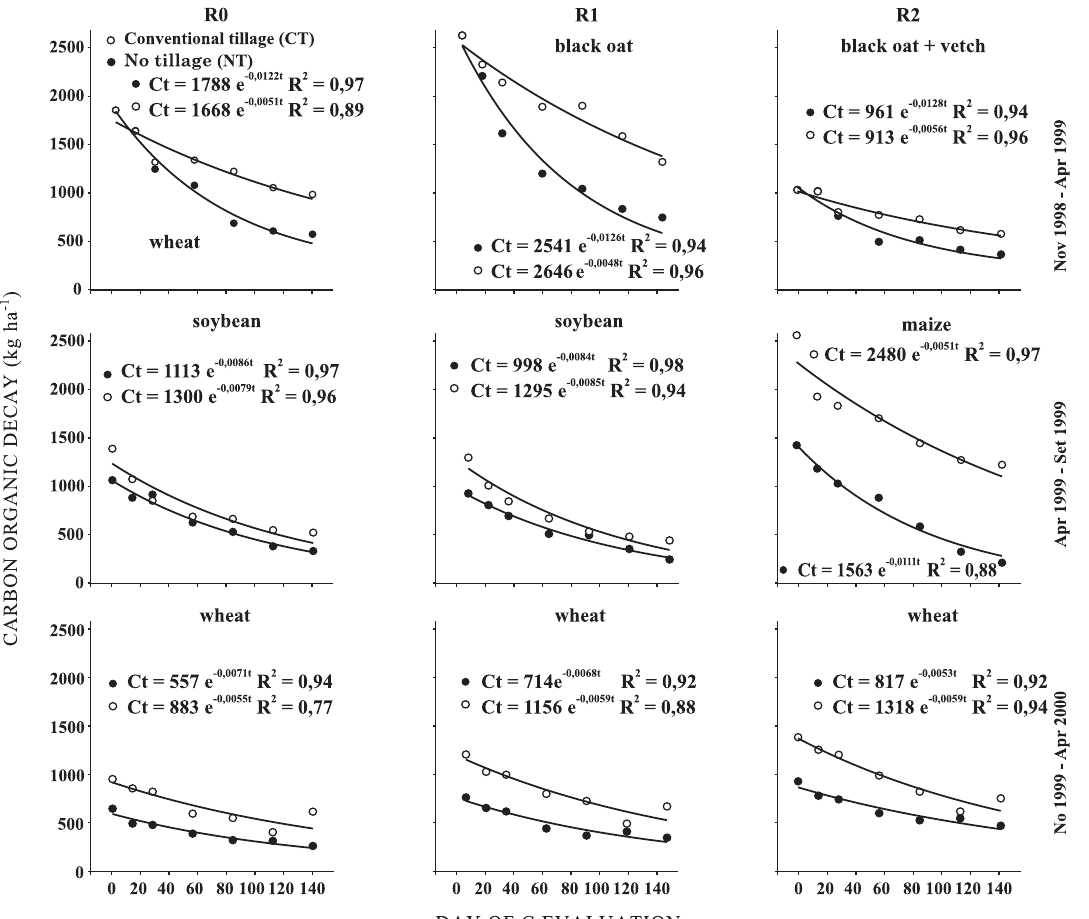
Figure 2. Carbon decay (Ct) of crop residue adjusted to a negative exponential model (Y = C conventional tillage (CT) and no tillage (NT) and cropping systems (R0: soybean/wheat; R1: soybean/ wheat/soybean/ black oat; R2: soybean/black oat/soybean/black oat+ common vetch/maize/oilseed radish/ wheat) during three periods of